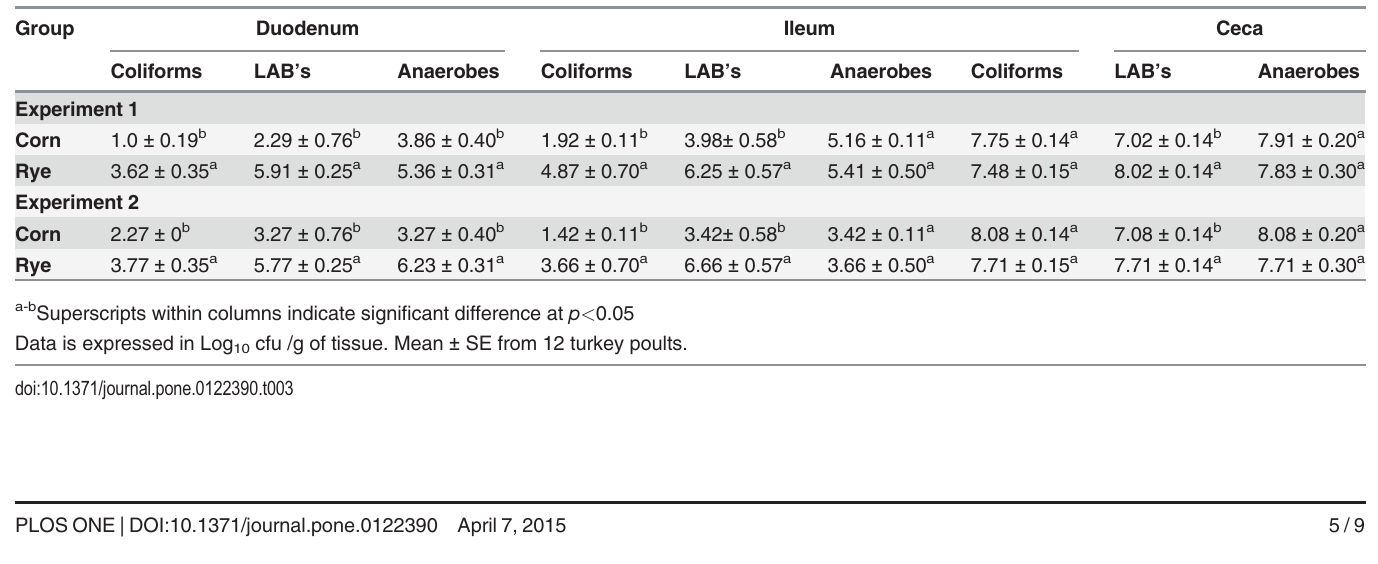
Table 3. Evaluation of total bacterial counts in duodenum, ileum, or ceca in turkey poults fed with corn or rye in Experiments 1 and 2. Group